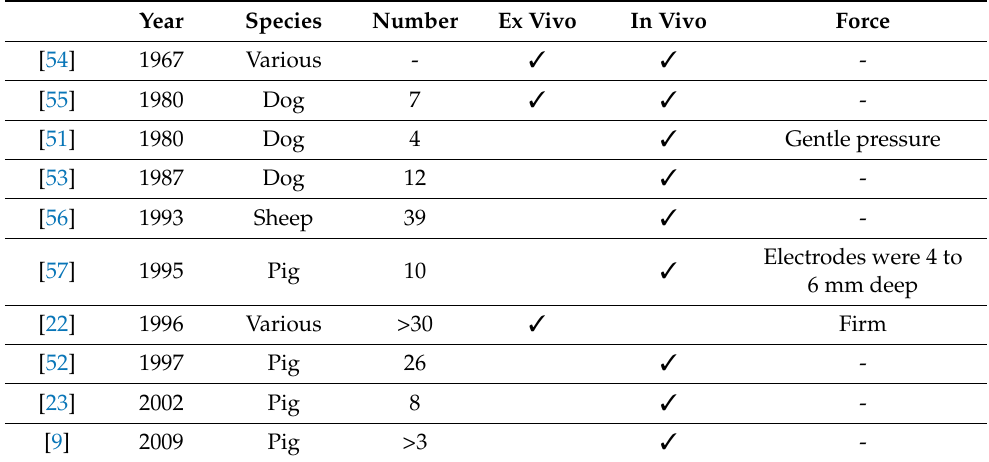
Table 1. Contact force reported by the ten studies investigating heart muscle conductivity from the IT’IS Foundation database and how the contact pressure during the measurement is described.